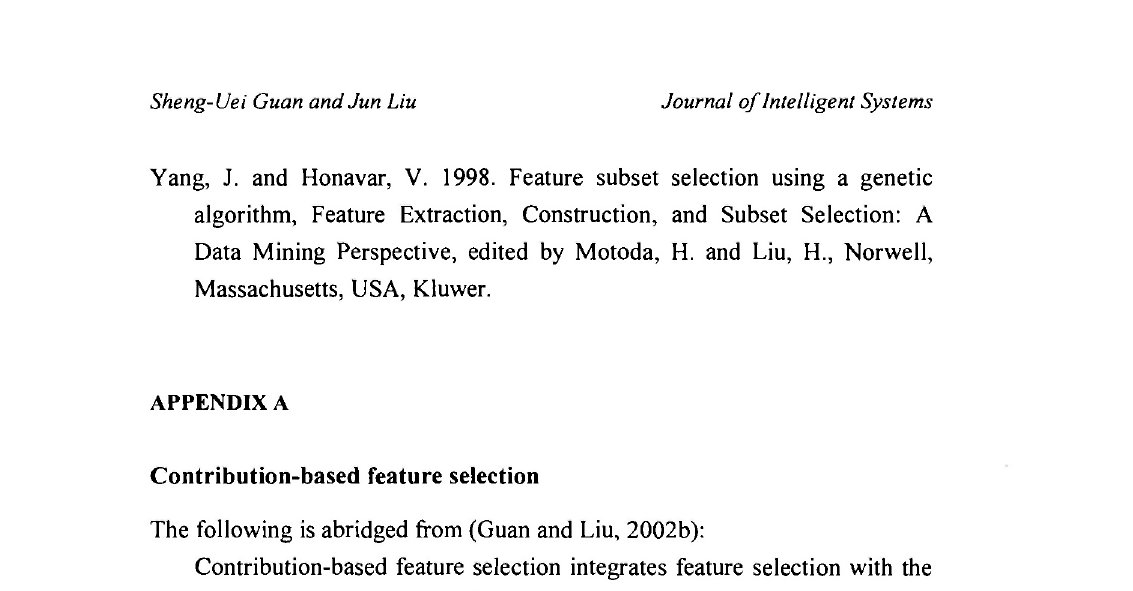
algorithm, Feature Extraction, Construction, and Subset Selection: